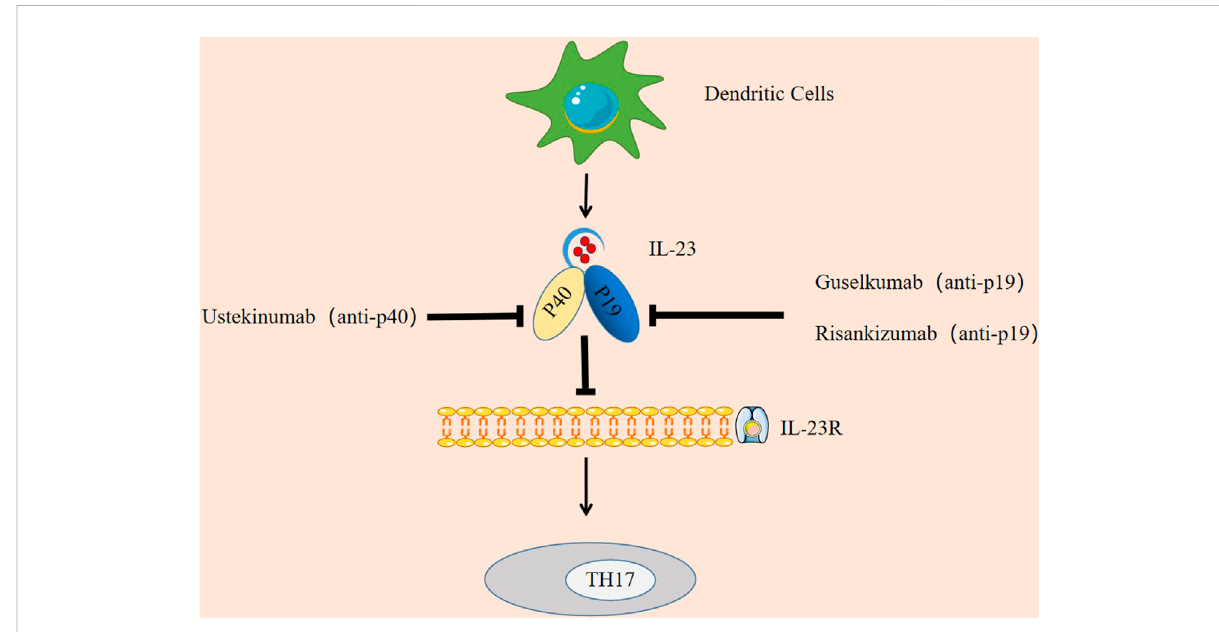
Targeting IL-23 in autoimmune diseases. IL-23 inhibitors have been shown to be effective. Ustekinumab is an inhibitor targeting IL-23p40, Guselkumab andRisankizumab are speci fi cinhibitorstargetingIL-23p19. They each block theIL-23 signaling pathway by bindingto thep40 subunit and p19 subunit, thereby inhibiting the immune response of